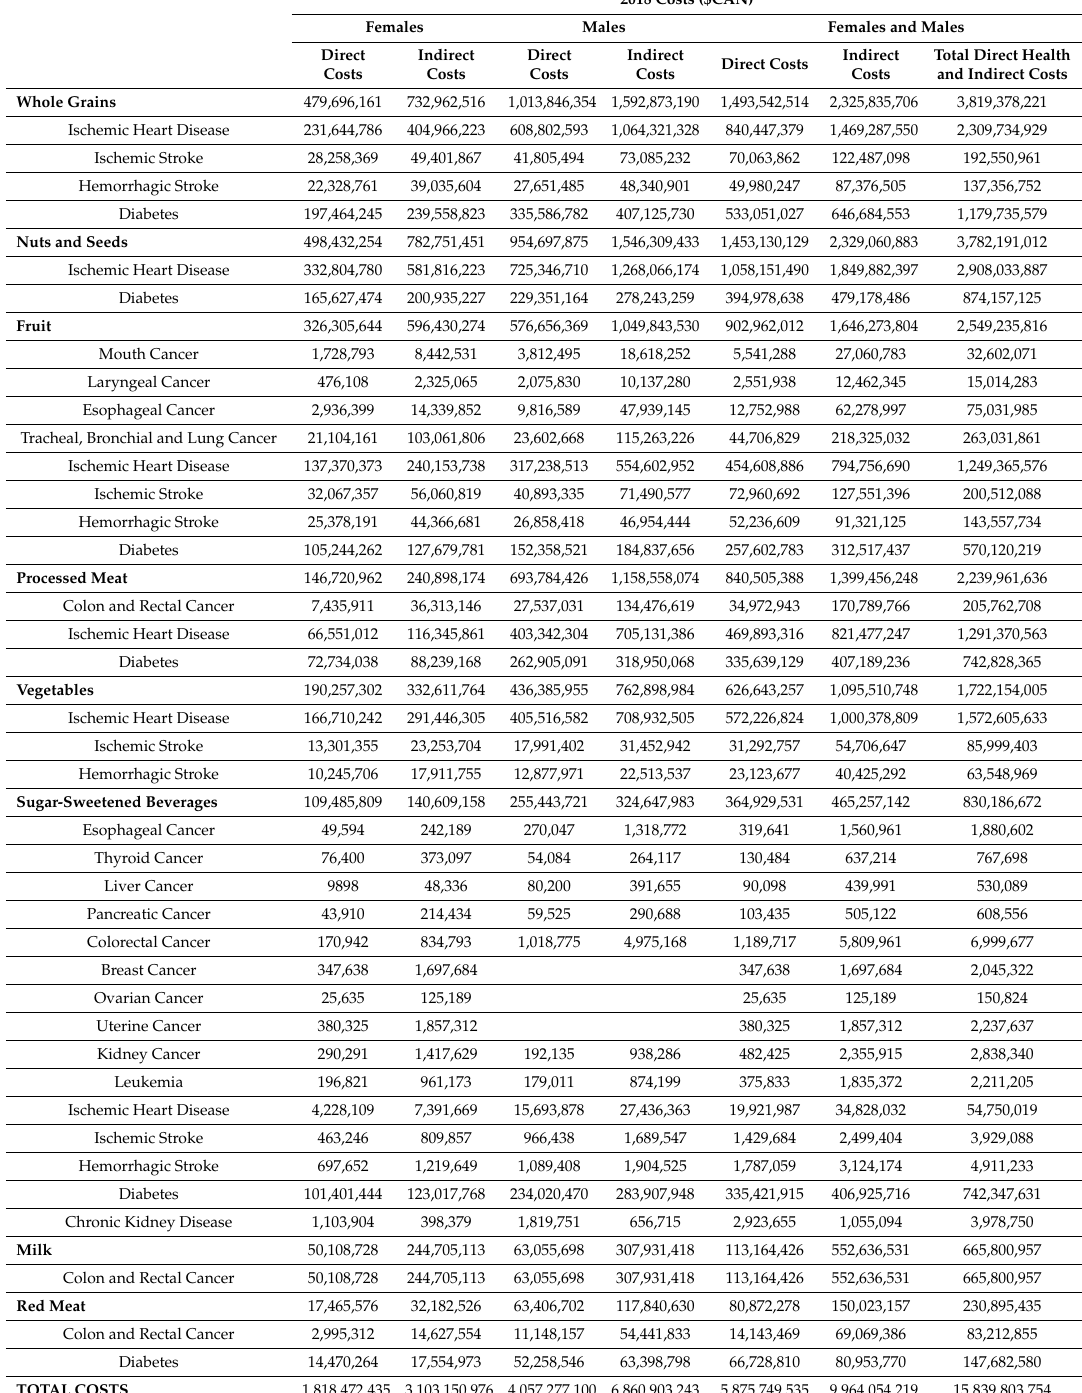
Table 4. Economic burden in Canada in 2018 of the eight foods that have established